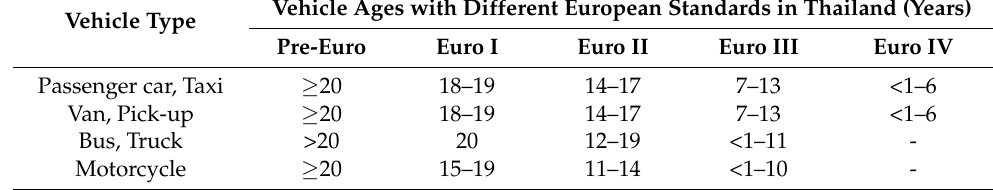
Table 2. Vehicles ages with different European emission standards in Thailand .